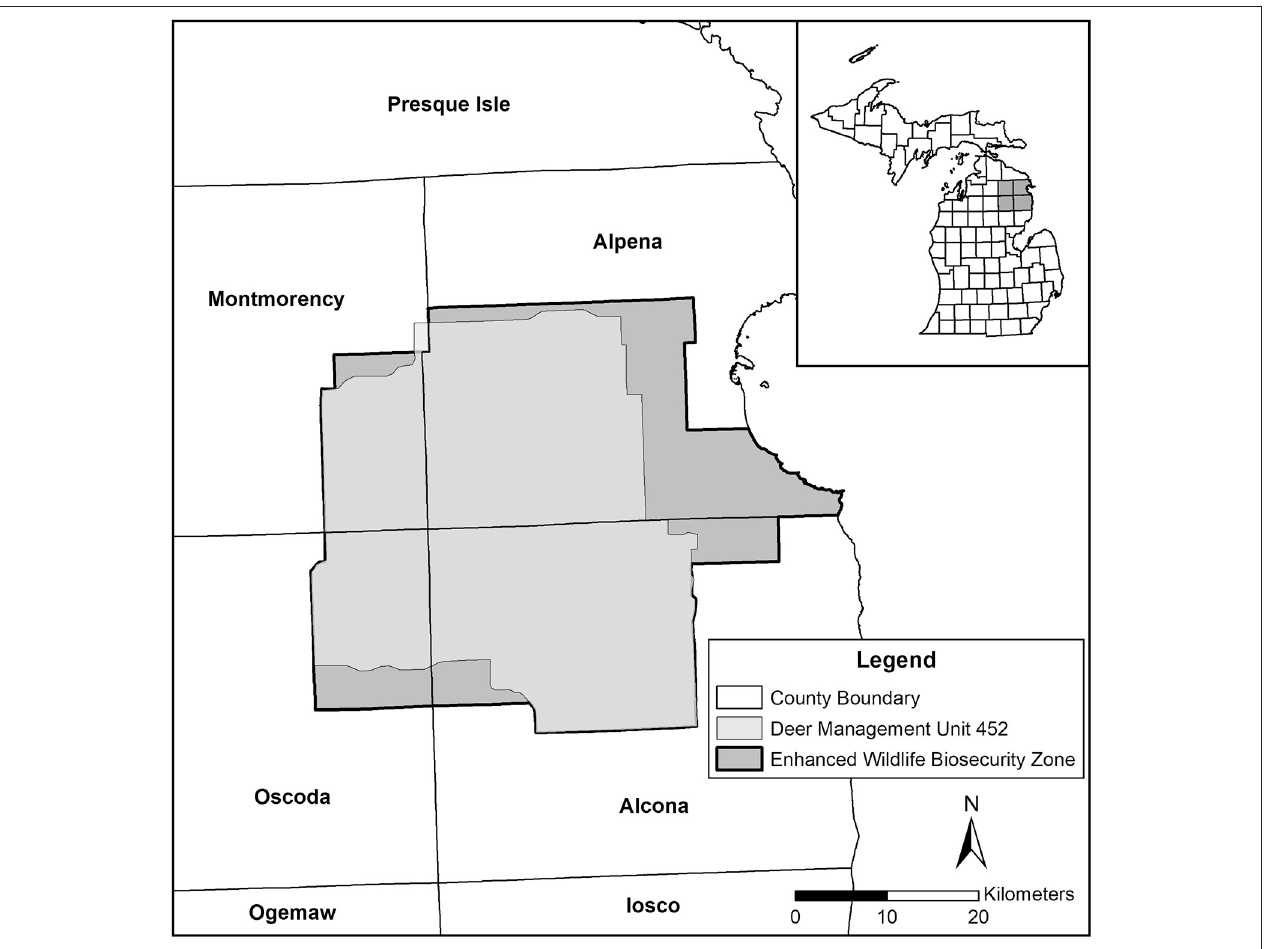
FIGURE 1 | Area of endemic bovine tuberculosis infection in both livestock and wildlife in Michigan, USA, often referred to as the “4-county area” or Deer Management Unit 452 (149,018 ha). The Enhanced Wildlife Biosecurity Zone is an area with increased disease mitigation efforts focused on separating cattle and white-tailed deer ( Odocoileus virginianus